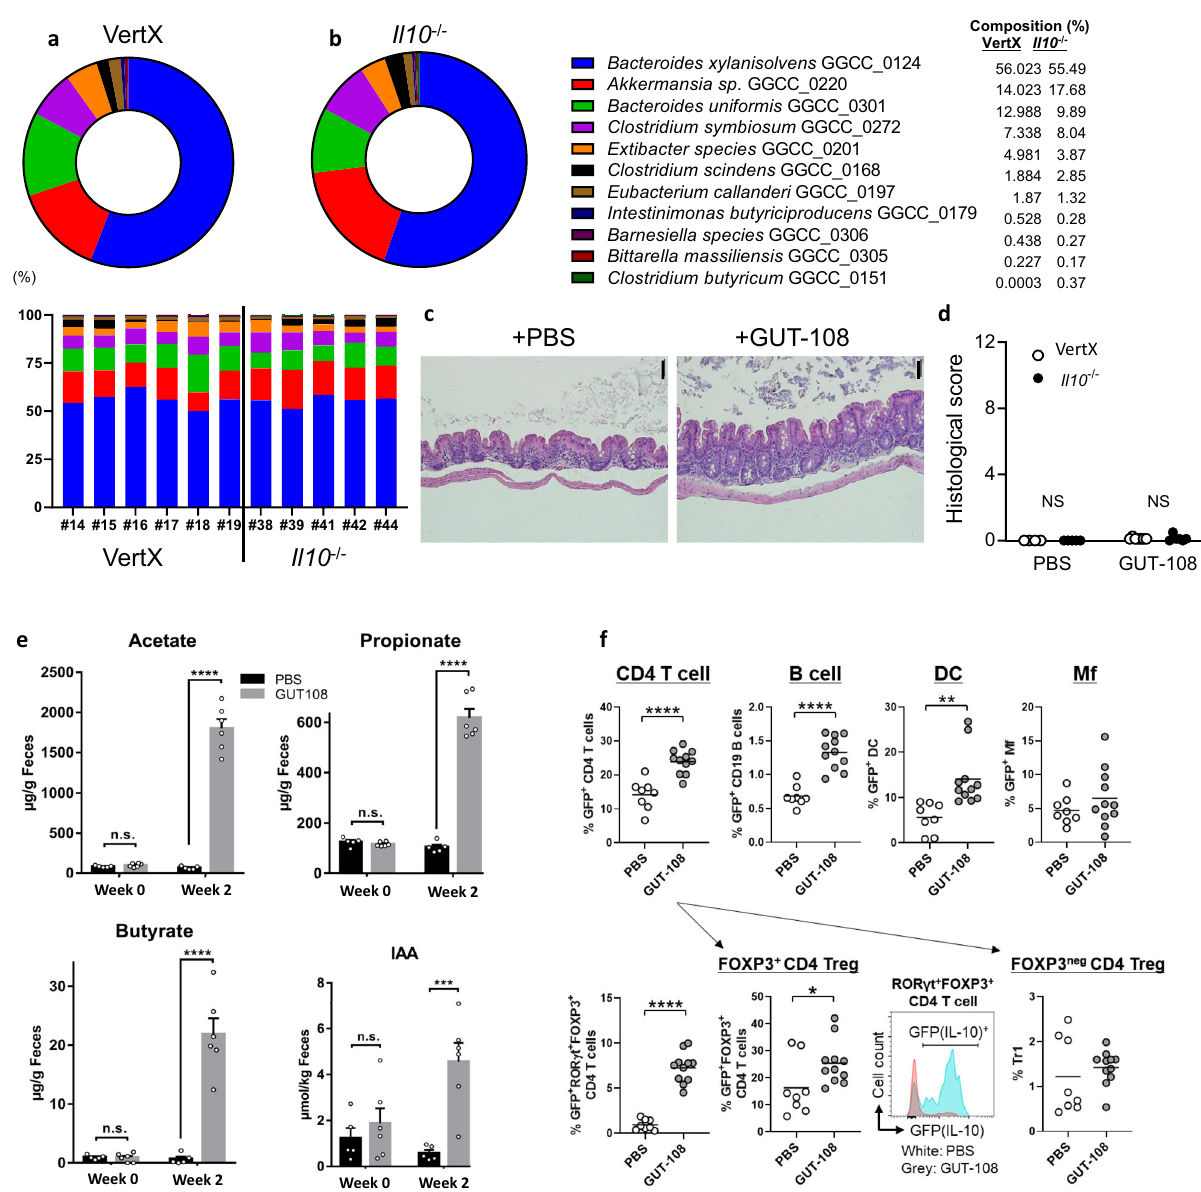
Fig. 3 Effect on the gut microbiome community composition, colonic histology, and fecal metabolomics of gnotobiotic mice inoculated with GUT-108 or treated with PBS for 2 weeks. Il10 + / eGFP VertX reporter mice ( a ) or Il10 − / − mice ( b ) were inoculated via gavage with GUT-108 (2 × 10 + 7 cfu/ strain), and after 2 weeks community composition of the gut microbiome was determined on cecal contents using qPCR with species-speci fi c primers. The average community composition (circle diagram) as well as the individual community composition for six Il10 + / eGFP VertX reporter mice and fi ve Il10 − / − mice are presented. The lower detection limit for qPCR was >0.0001%. c Representative distal colonic photomicrographs of H&E-stained tissue showing the lack of colonic in fl ammation two weeks after inoculation of gnotobiotic Il10 − / − mice with GUT-108 or PBS. The experiment was repeated independently with similar results for each animal in the GUT-108 ( N = 11) or PBS ( N = 8) group. The bar (upper right corner) in the pictures indicates 100 µ m. d Histological scoring showing the lack of colonic in fl ammation 2 weeks after inoculation of gnotobiotic Il10 + / eGFP VertX reporter mice or Il10 − / − mice with GUT-108: combined score of cecum, proximal colon, and distal colon/rectum. Two-Way ANOVA with Sidak ’ s multiple comparison test. NS not signi fi cant. N = 5 – 6/group. e Metabolite analysis of fecal material from Il10 − / − mice inoculated with GUT-108 to con fi rm